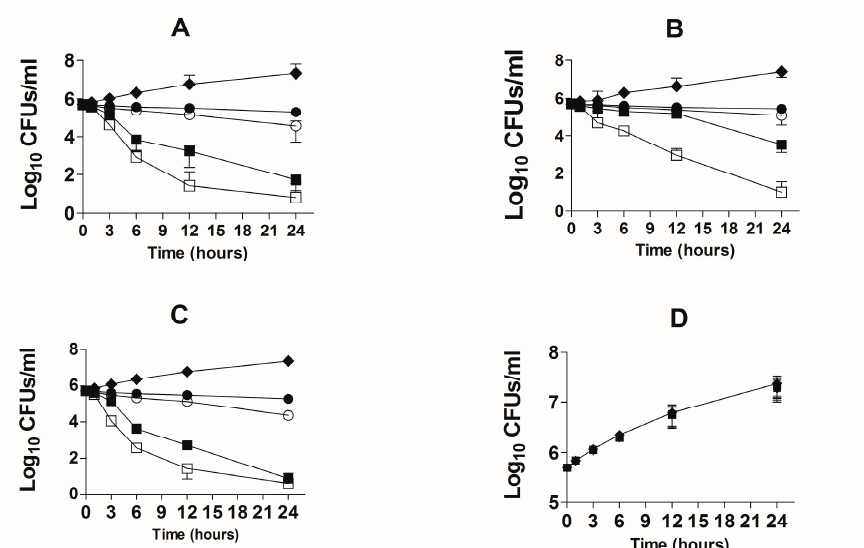
Figure 5. Time-kill curves of TQ or AMX at the doses of 1, 2, 4 and 8 μ g/mL against the drug-sensitive and drug-resistant A. baumanni . Time-kill curves of TQ against the ( A ) drug-sensitive and ( B ) drug-resistant A. baumannii . Time-kill curves of AMX against the ( C ) drug-sensitive and ( D ) drug-resistant A. baumannii . The data are represented as the means ± SD of three independent experiments. Control (  ), TQ—1 μ g/mL or AMX—1 μ g/mL (  ), TQ—2 μ g/mL